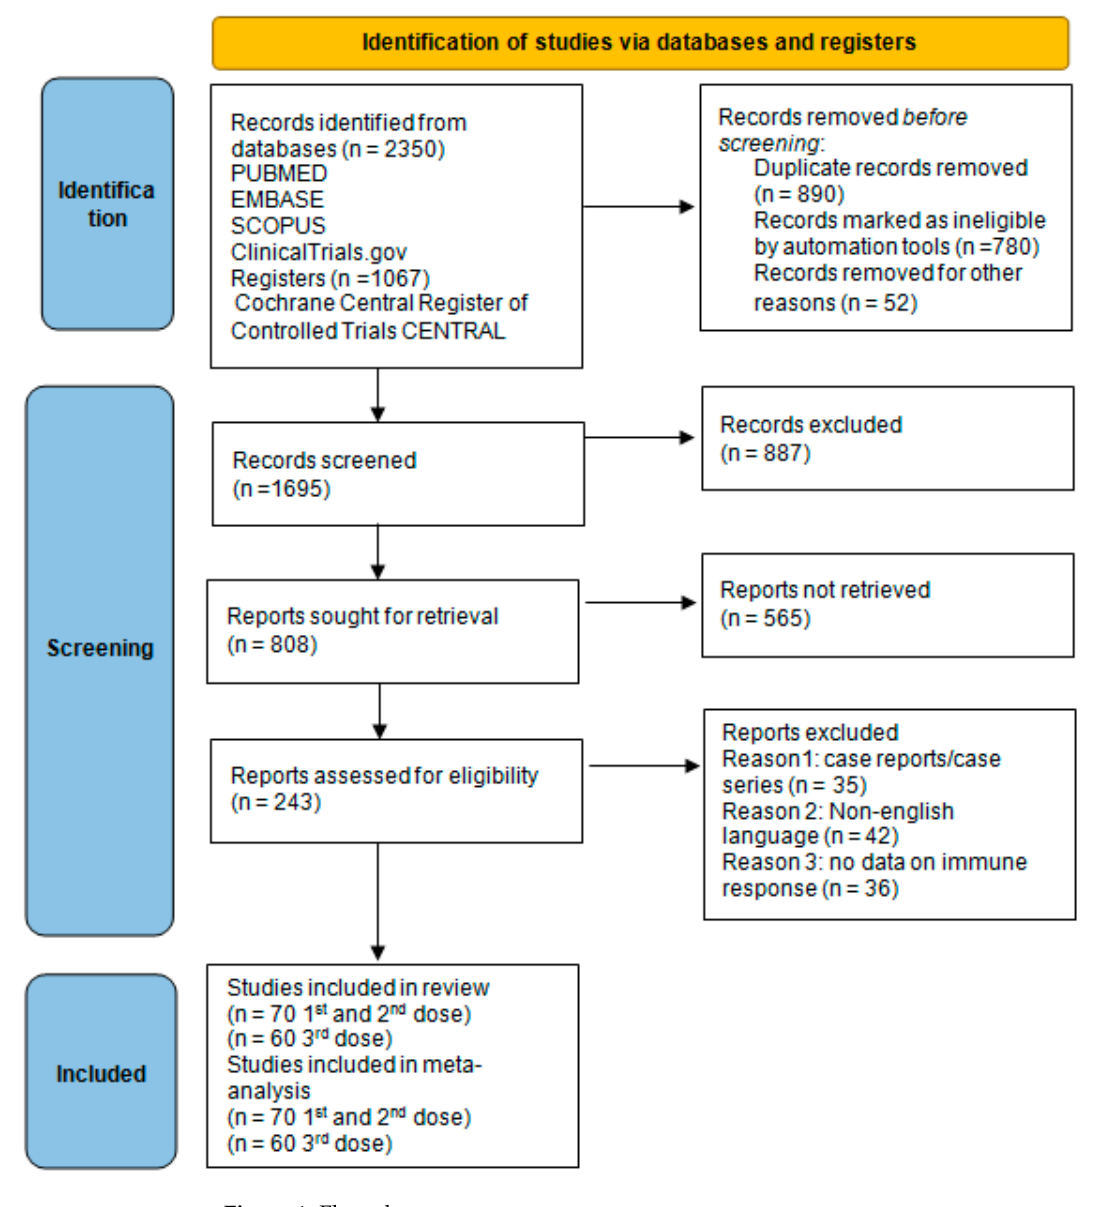
Figure 1. Flow chart.